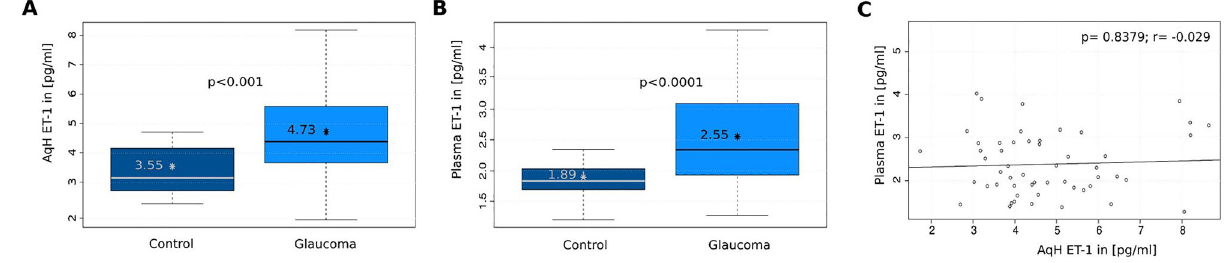
Figure 2. ( A , B ) ET-1 level of ( A ) AqH and ( B ) plasma samples from cataract and glaucoma patients. ( C ) Spearman rank correlation of plasma ET-1 level to AqH ET-1 level in the glaucoma significant difference in the number of topical antiglaucomatosa between the three IOP groups (Kruskal Wallis p = 0.4938; data not shown). Furthermore, elevated plasma ET-1 level of glaucoma patients correlated significantly positively with age (p = 0.035; Table 2), refraction (p = 0.031; Table 2), vertical CDR (p = 0.044; Table 2) and disc area (p < 0.01; Table 2) and significantly negatively with IOP (p = 0.030; Table 2). Additionally, the plasma ET-1 level of patients with glaucoma correlated significantly with reduced superior RNFL thickness (p = 0.049 Table 2), while no correlation was found with reduced inferior RNFL thickness (Table 2), nor between AqH ET-1 level and superior/inferior RNFL thickness loss (Table 2, Supplemental Table 3). Furthermore, several negative correlations between plasma ET-1 level and VD were identified (Table 2, Sup- plemental Table 3): In the peripapillary region, there was a negative correlation with the plasma ET-1 level in the temporal superior sector (PeriONH TempSup). In the macular region, the measurement areas Fovea SVP, Fovea DVP and the FAZ correlated negatively with the plasma ET-1 level (Table 2; Supplemental Table 3). There was no significant correlation between AqH and ET-1 levels in the glaucoma group. ET-1 levels in both plasma (r = 0.296, p < 0.01) and AqH (r = 0.269, p = 0.024) correlated significantly positively with the OCT GSS score of the entire study population. To determine whether the elevated ET-1 level might be related to an enhanced protein concentration in the respective samples from glaucoma patients, we analysed the protein concentration of AqH and plasma samples. Protein concentration was found to be significantly elevated compared with the control group (Supplementary Table 1) and correlated positively with the elevated ET-1 level measured in the respective plasma samples (AqH r = 0.22, p = 0.13; plasma r = 0.33, p < 0.01). Furthermore, the plasma protein concentration correlated positively with increasing OCT GSS score (r = 0.23; p = 0.031), but no further correlations with age, IOP, lens status or OCT parameters were detected. Multivariable analysis: plasma ET‑1 level as predictor of retinal VD.